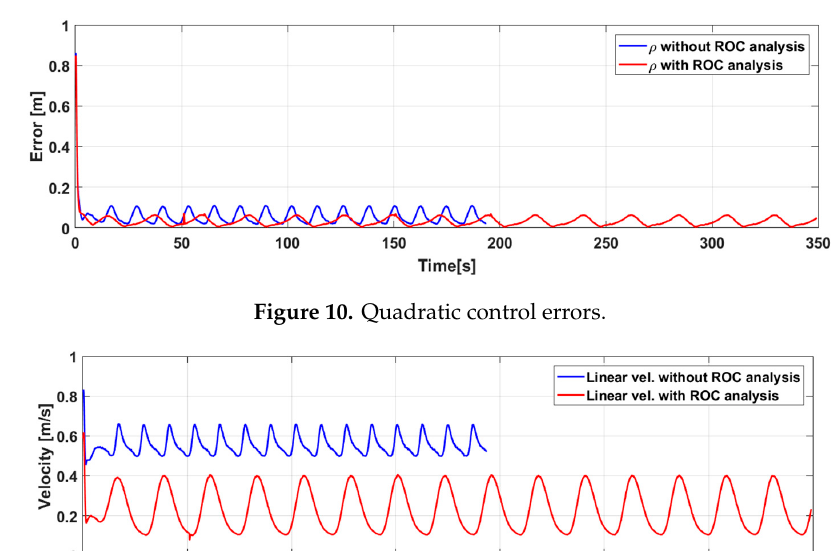
Figure 10. Quadratic control errors.